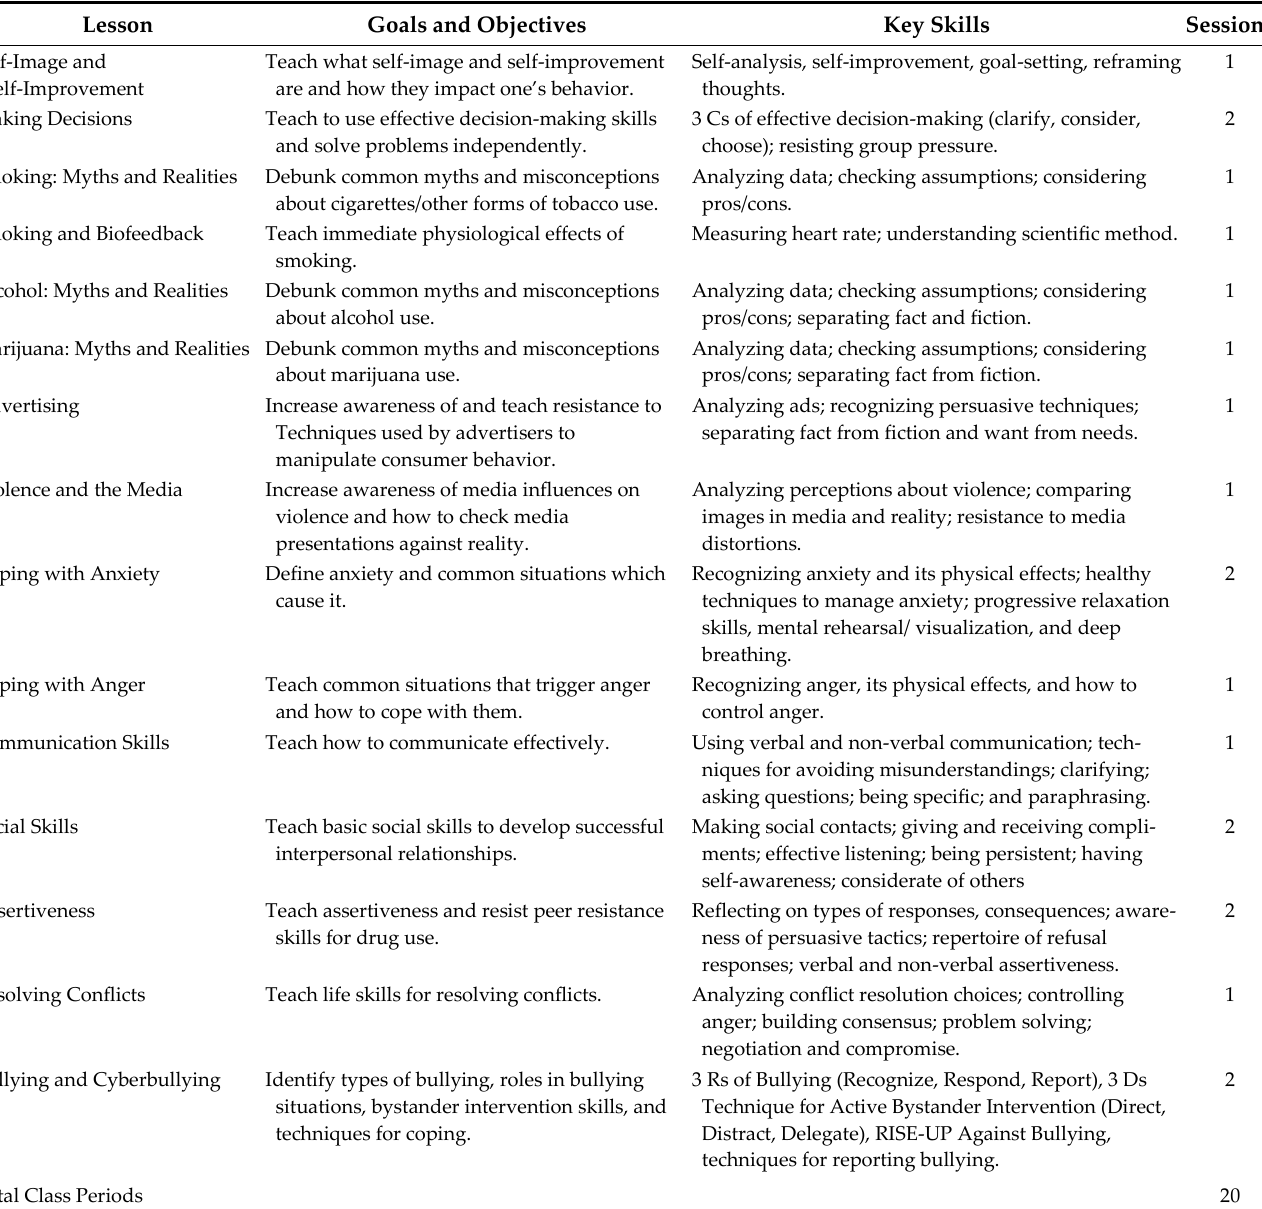
Table 1. Program Sequence for the LST Classroom Program with Bullying Content.